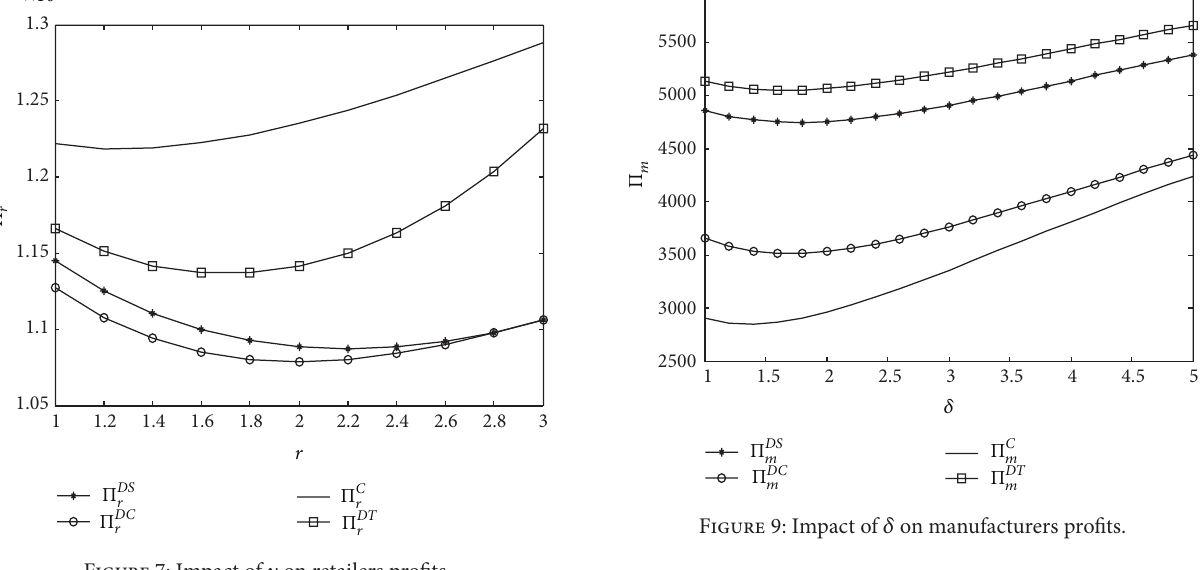
Figure 7: Impact of 𝛾 on retailers profits.